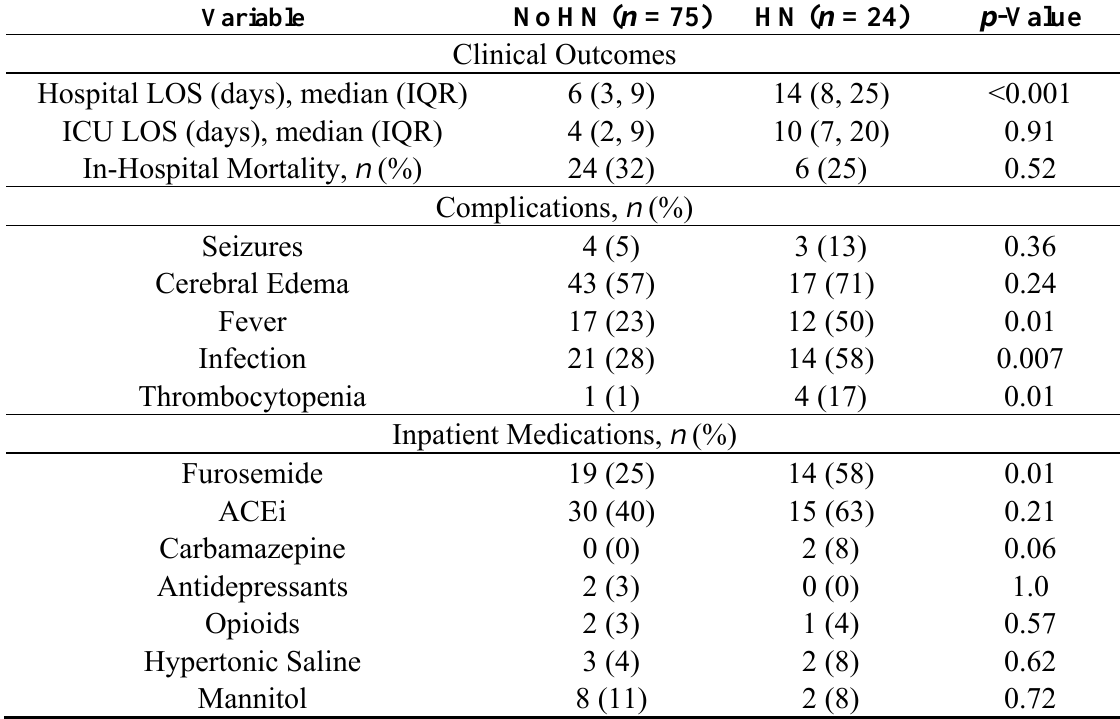
Table 3. Clinical outcomes, ICU complications, and ICU patient medications: HN, hyponatremia; LOS, length of stay; ICU, intensive care unit; ACEi, angiotensin converting enzyme